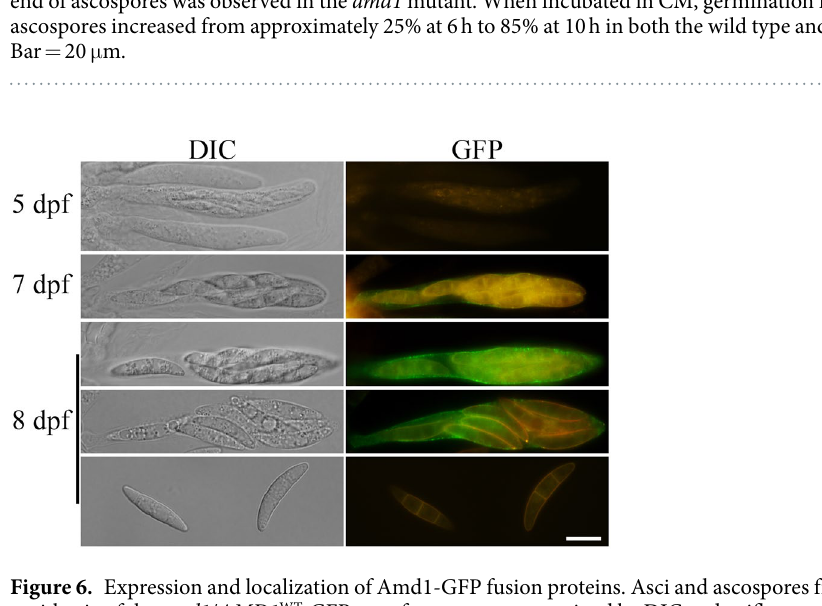
Figure 6. Expression and localization of Amd1-GFP fusion proteins. Asci and ascospores from 5, 7 and 8 dpf perithecia of the amd1 / AMD1 WT -GFP transformant were examined by DIC and epifluorescence microscopy. Bar = 10 μ m. Ascospores outside asci had no GFP